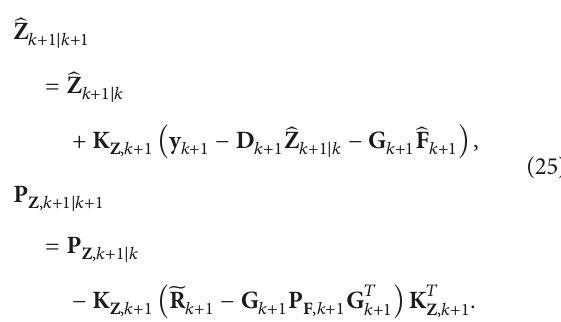
By substituting (23) into (18) and (22), respectively, we can obtain the following expression: